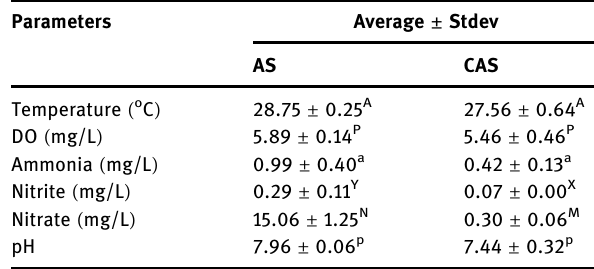
Table 2: Proximate composition of fi sh reared in either the aqua - ponics system or conventional aquaculture system for 30 days Performance index